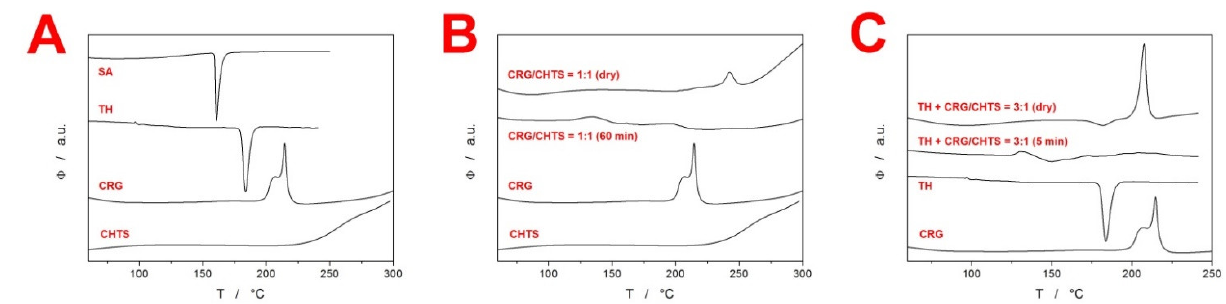
Figure 1. ( A ) DSC curves obtained at 30 °C·min −1 for the major pure components of the present matrix tablets. ( B ) DSC curves for the dry and wetted (within the standard acidic dissolution procedure) binary CRG/CHTS tablets and their pure components. ( C ) DSC curves for the dry and wetted (within the standard acidic dissolution procedure) example TH-containing formulation (F18) and their pure substances.